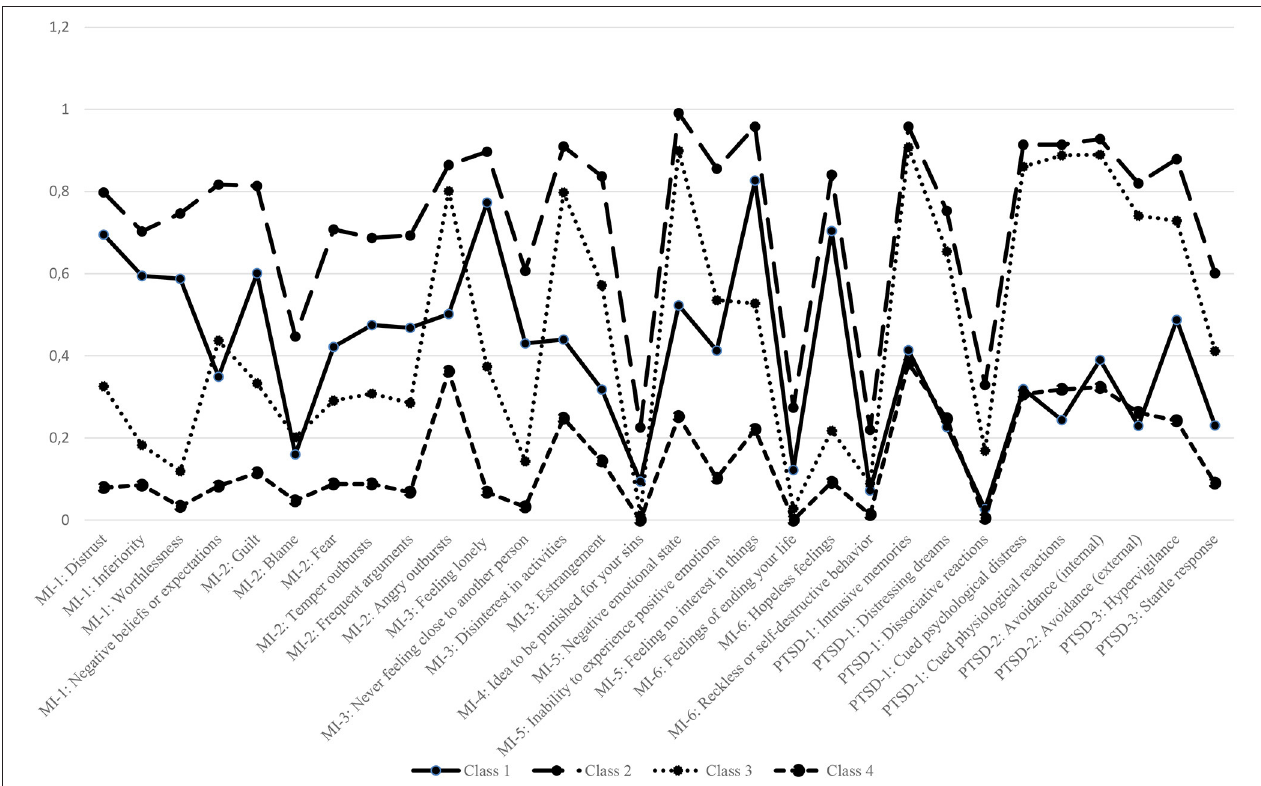
FIGURE 1 | Symptom endorsement probability for the four-class solution. MI, moral injury; PTSD, post–traumatic stress disorder. *For full description of the items; see Table 2